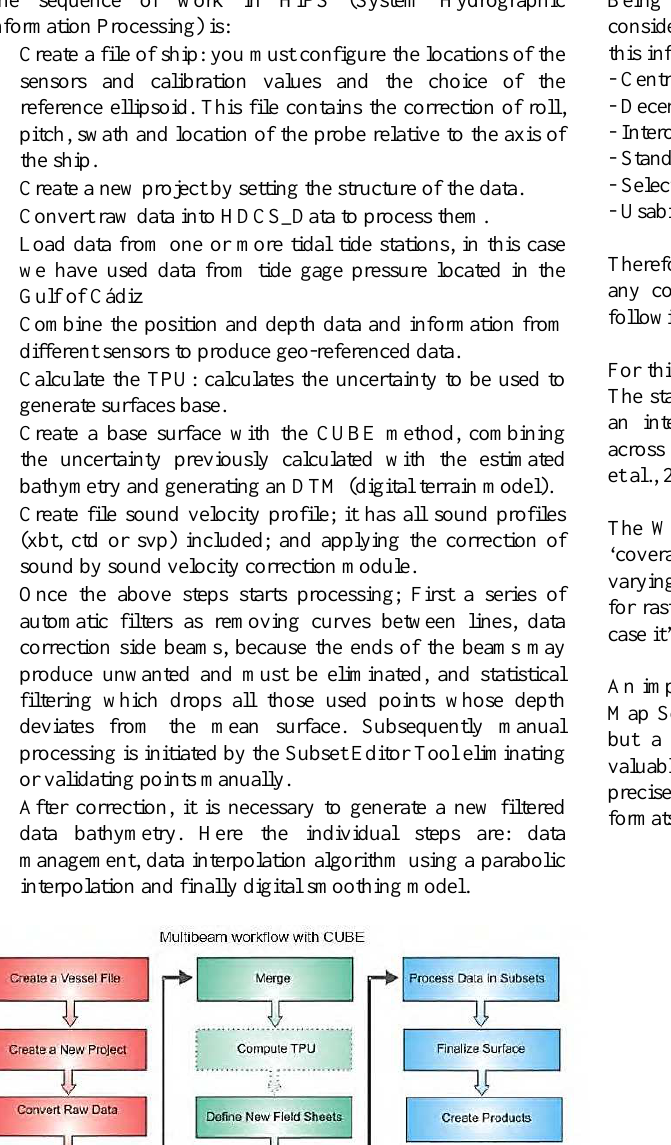
Figure 6. Processing workflow with CARIS-HIPS